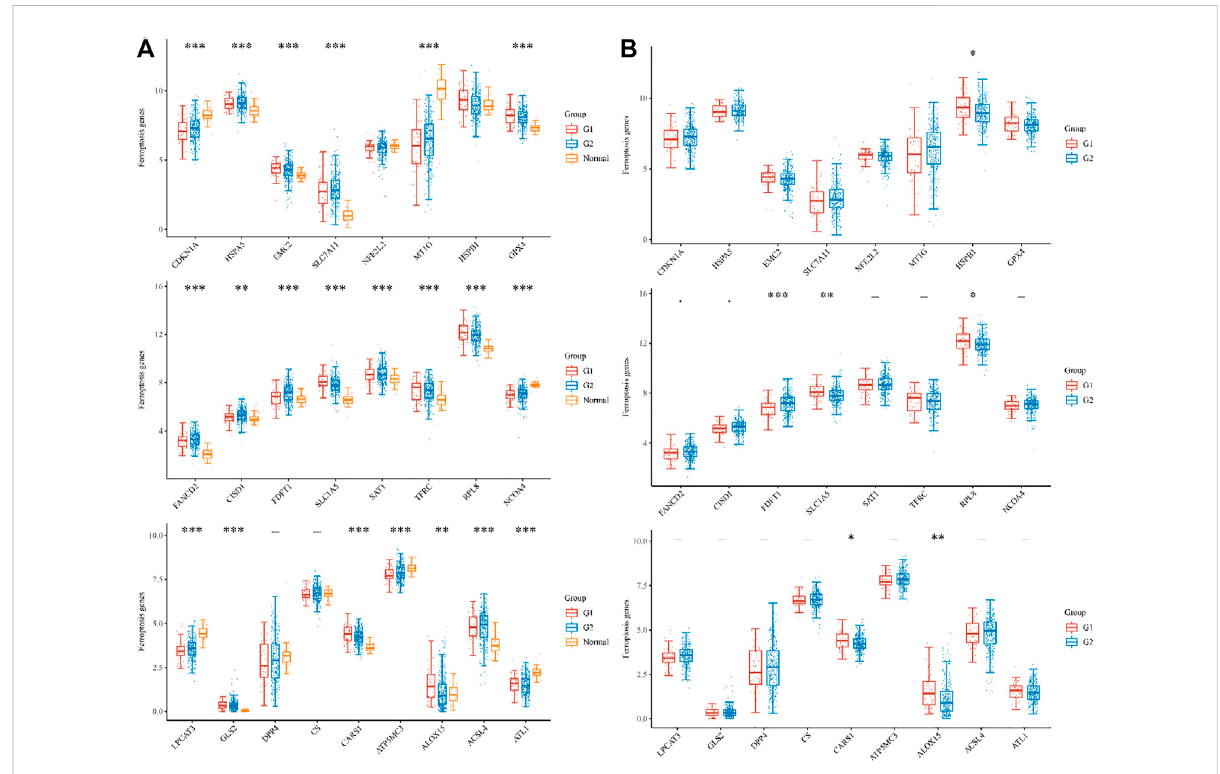
FIGURE 1 The expression distribution of ferroptosis-related mRNA in tumor tissues and normal tissues. (A) histogram shows the dysregulation of iron death in metastasis G1, non-metastases G2, and Normal samples, respectively. (B) histogram shows the number of signi fi cantly differentially expressed genes in metastasis G1, non-metastases G2, respectively. * p < 0.05, ** p < 0.01, *** p <